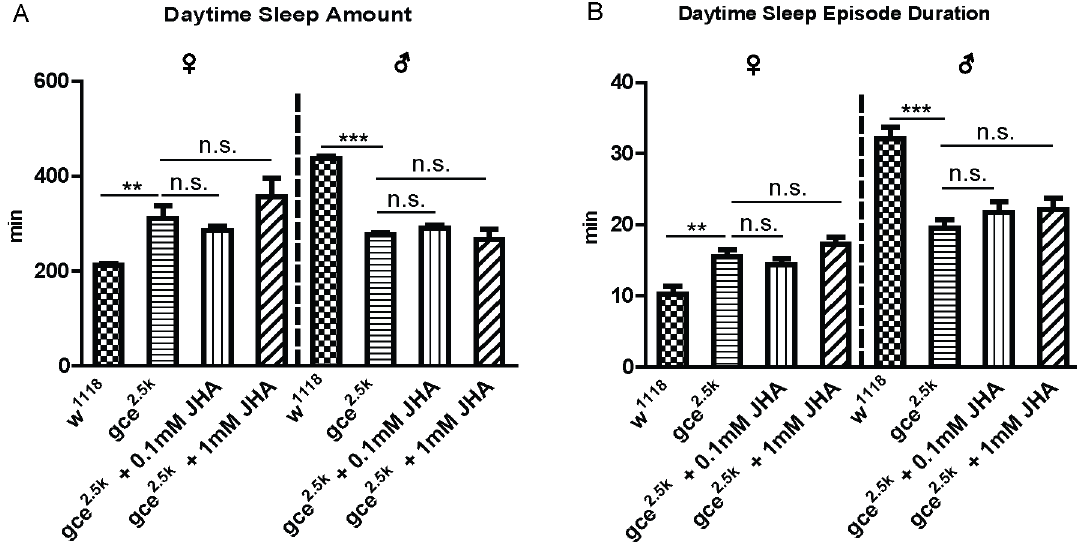
Fig 3. Effects of JH receptor gce mutations on sleep behavior. (A) Gce mutation increased the female daytime sleep amount and decreased the male daytime sleep amount, while neither 0.1mM nor 1mM JH analog could rescue the mutant phenotypes. Data represent mean±SEM(n = 32–96). n.s. represents no significant difference, (cid:3)(cid:3) P < 0.01, (cid:3)(cid:3)(cid:3) P < 0.001 determined by Student’s t test. (B) Sleep-bout duration of gce 2 . 5k flies was consistent with their daytime sleep amount. Data represent mean±SEM(n = 32–96). n.s. represents no significant difference, (cid:3)(cid:3) P < 0.01, (cid:3)(cid:3)(cid:3) P < 0.001 determined by Student’s t